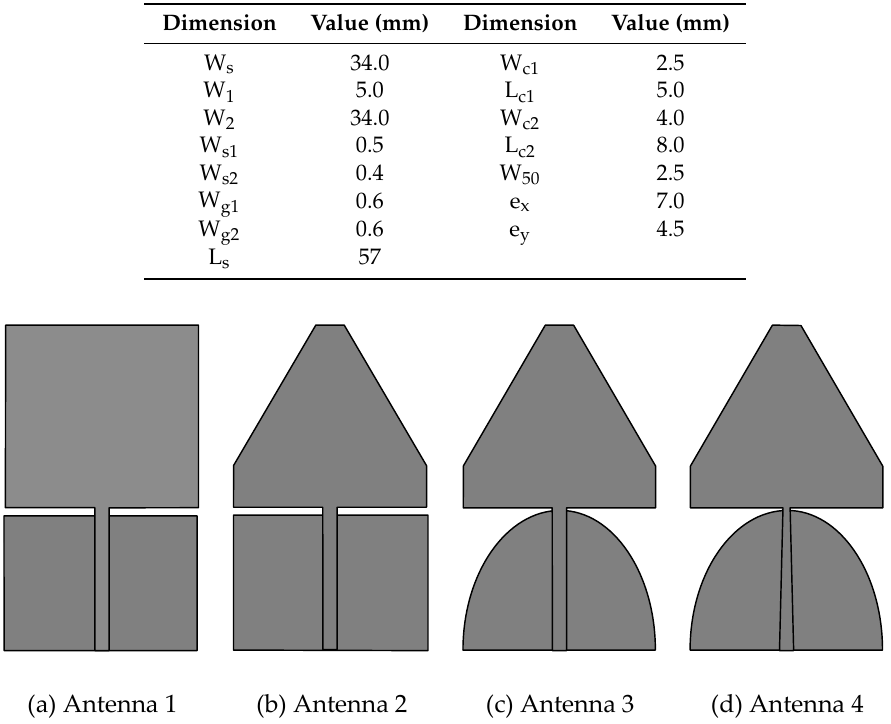
Figure 1. The geometry of a super-wideband (SWB) antenna with: ( a ) Rectangular ground and radiator; ( b ) rectangular ground and trapezoid radiator; ( c ) trapezoid radiator and semicircular ground; ( d ) semicircular ground, trapezoid radiator, and rectangular tapered feed.